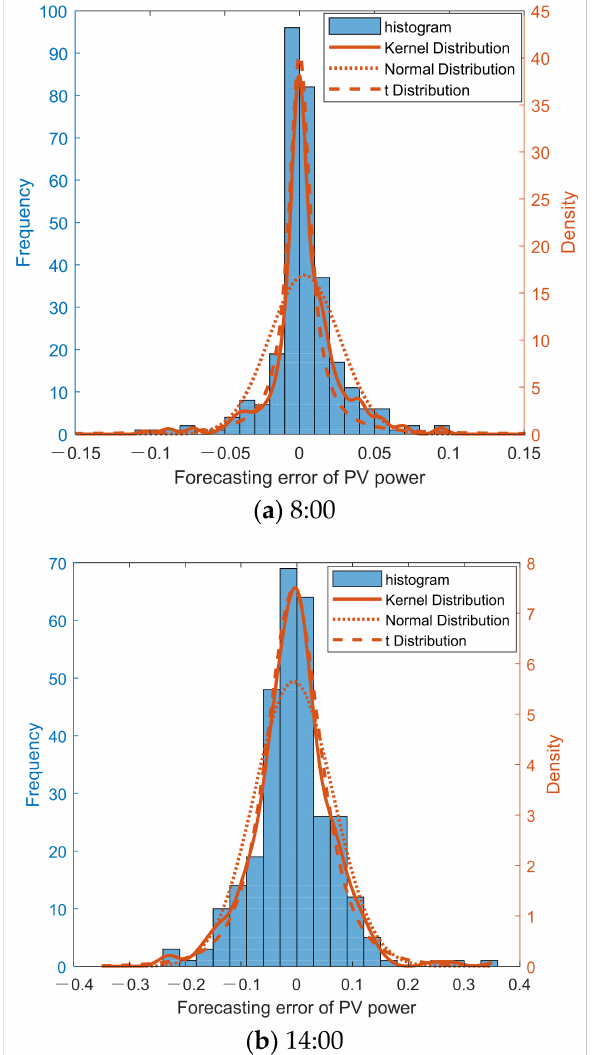
Figure 3. The histogram and distribution function curve of PV forecasting